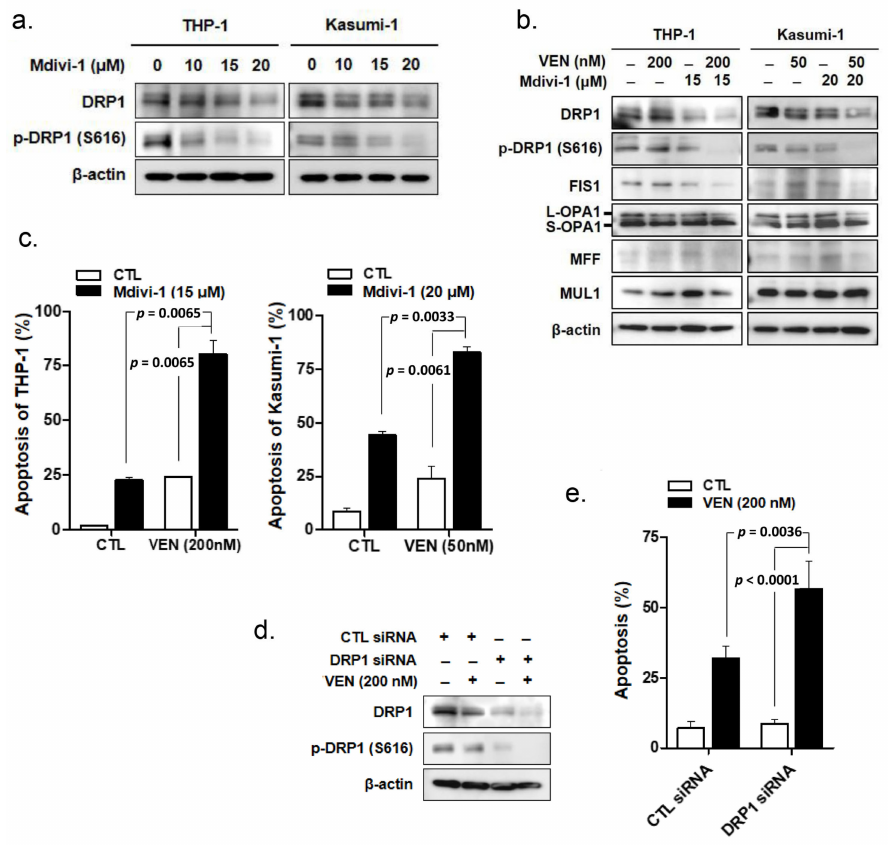
Figure 2. DRP1 inhibition enhances venetoclax-induced apoptosis in TP53mut leukemia